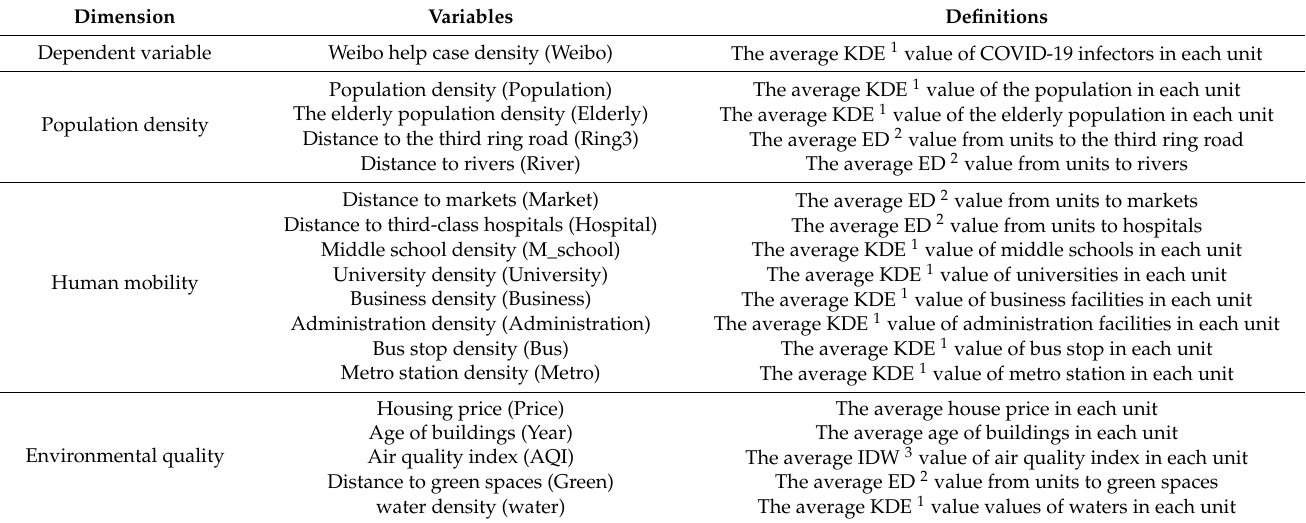
Table 4. Variable